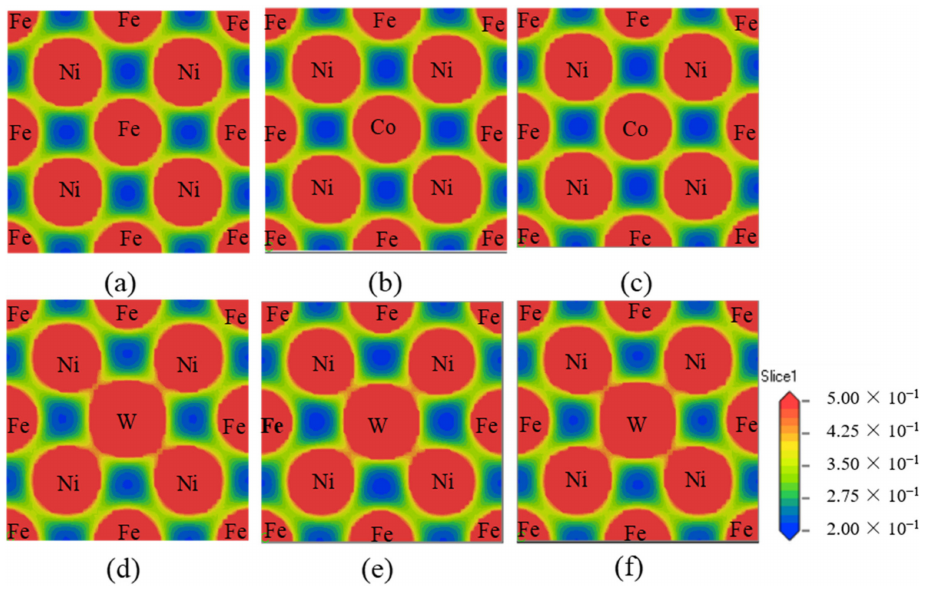
Figure 4. Charge density distribution maps of di ff erent systems in (010) plane: ( a ) Fe16Cr8Ni8; ( b ) Fe15Cr8Ni8Co; ( c ) Fe14Cr8Ni8Co2; ( d ) Fe15Cr8Ni8W; ( e ) Fe14Cr8Ni8W2 and ( f )